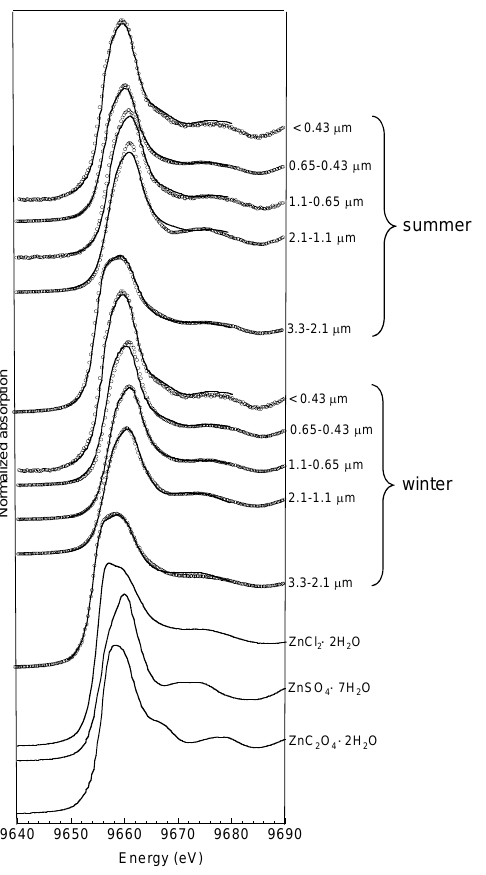
Fig. 5. Zinc K-edge XANES spectra (open circles=samples, lines=fitting) of finer particles during winter and summer at Tsukuba with those of the standard materials used for fitting.